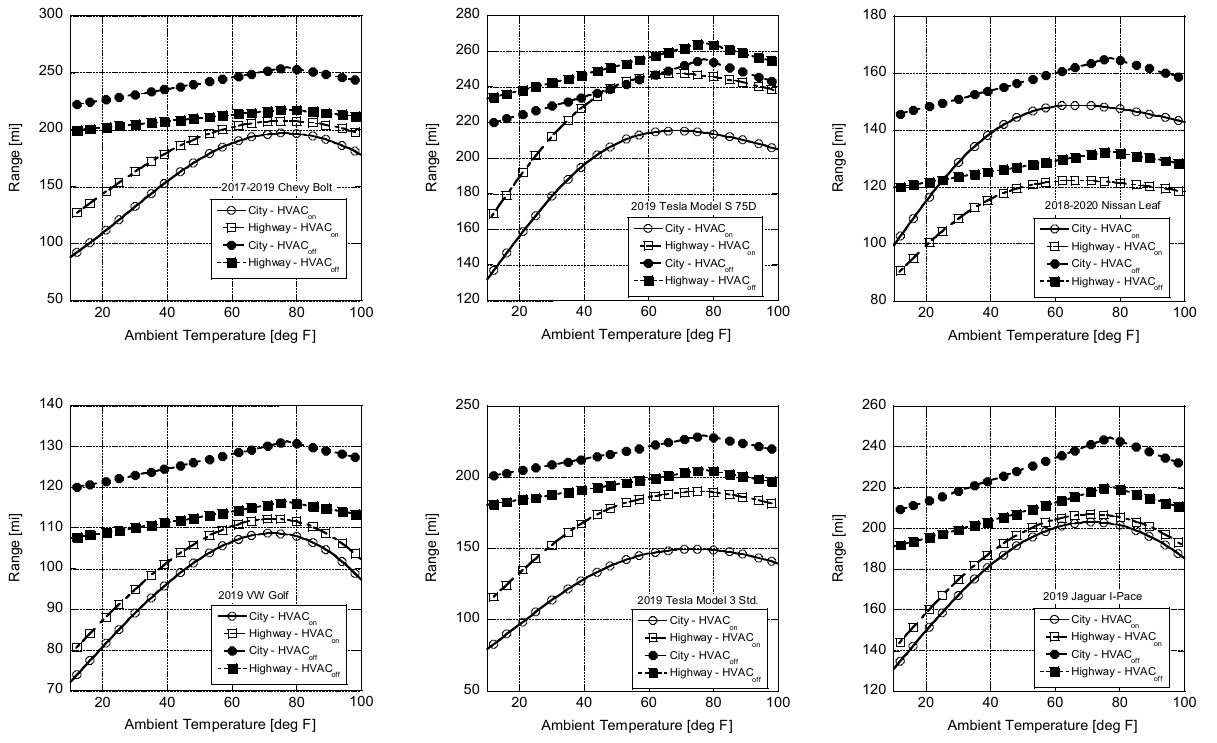
Figure 14. Range of the different modeled vehicles based on ambient temperature with the HVAC system off (solid symbols) and HVAC system on (open symbols) for the SAE J1634 test procedure.